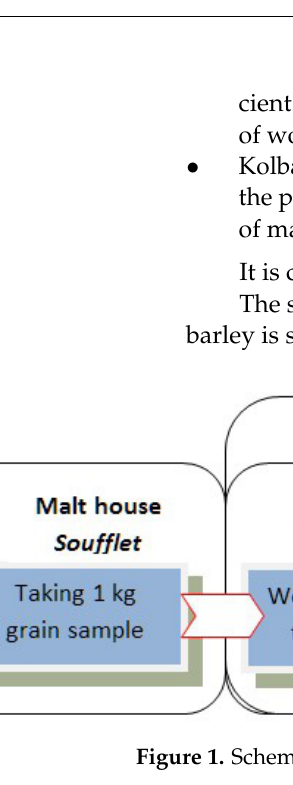
Table 1. Main technological features of selected varieties of malting barley [7]. T he bold is the leading result .